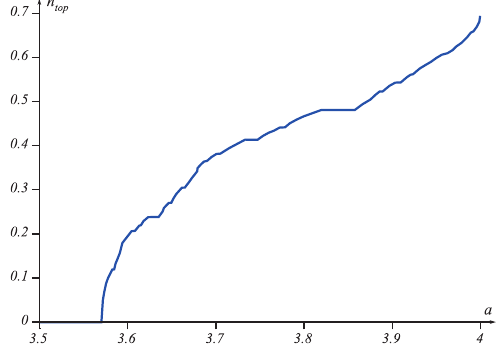
Fig. 3 The graph of topological entropy for the logistic map f a ( x ) = ax ( 1 − x )